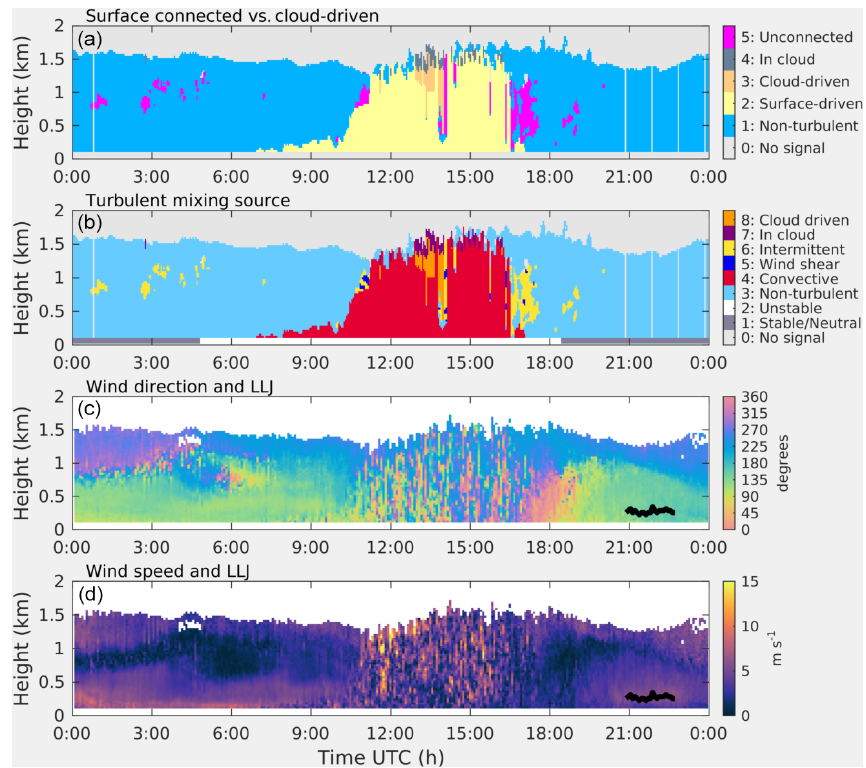
Figure 4. Time–height plots of atmospheric boundary layer classification using the Manninen et al. (2018) scheme showing (a) whether mixing is connected to the surface or cloud driven and (b) the turbulent mixing source, together with time–height plots of (c) wind direction and (d) wind speed on 28 August 2017 at Jülich, Germany. The black lines in (c) and (d) show low-level jet (LLJ) altitude (Tuononen et al.,